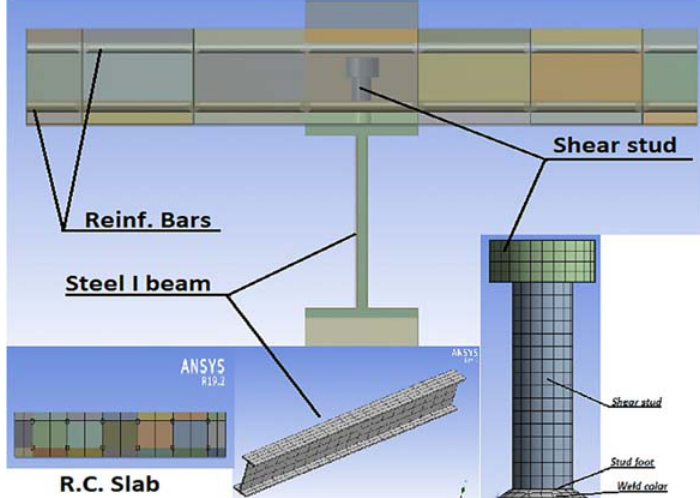
Figure 2: The finite element model used in the